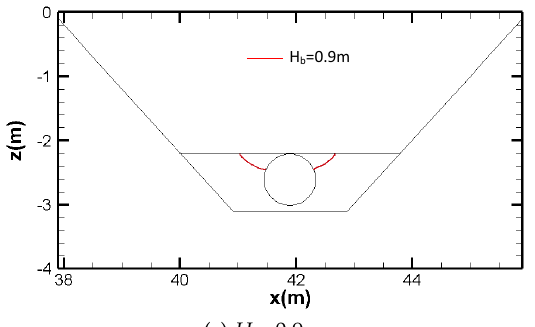
Figure 11. Distribution of the liquefaction depth around the partially buried pipeline for variable backfill depth.